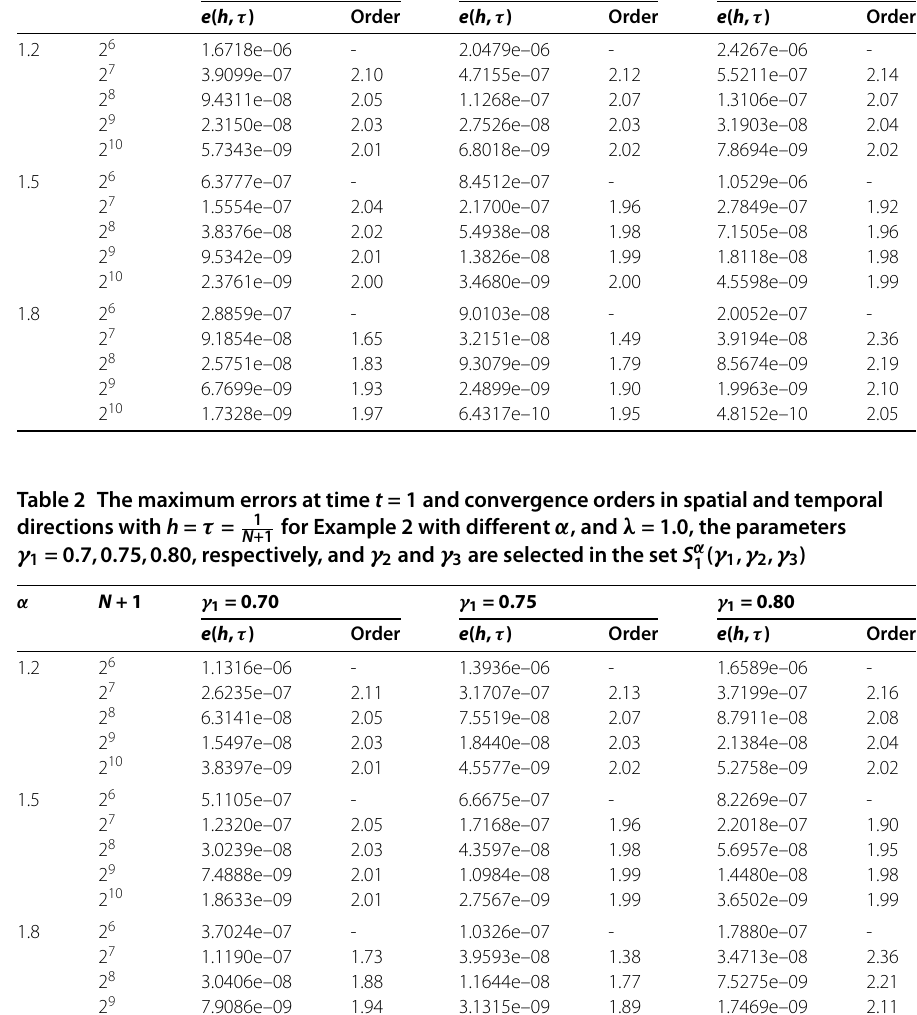
Table 1 The maximum errors at time t = 1 and convergence orders in spatial and temporal for Example 1 with different α , and λ = 1.0, the parameters directions with h = τ = 1 N +1 γ 1 = 0.7,0.75,0.80, respectively, and γ 2 and γ 3 are selected in the set S α